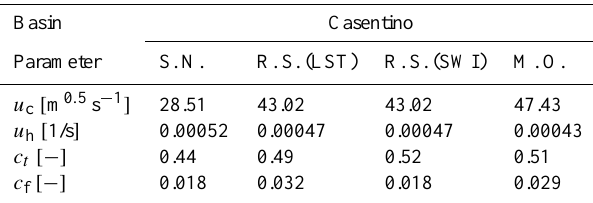
Table 9. The Casentino basin parameters were calibrated following the different approaches: using the multi-objective function (M. O.), remote-sensing data and morphologic characteristics (R. S.), and the standard hydrographs comparison (S. N.). The table reports the values obtained by the four different calibration